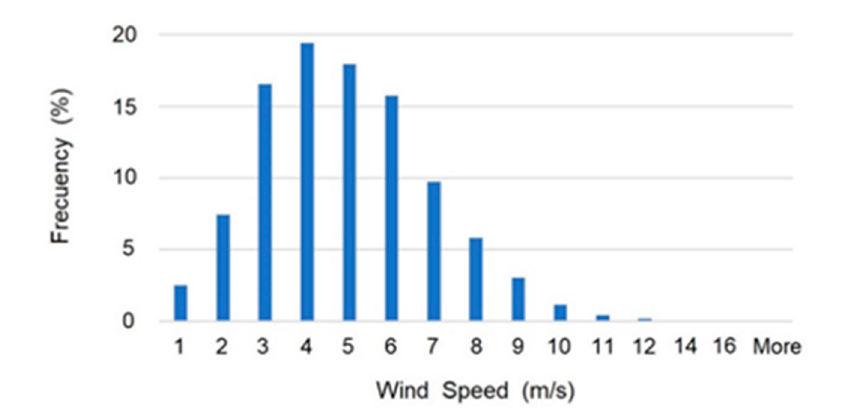
Figure 6. Histogram of wind speed with relative frequencies for each unit of magnitude of speed.